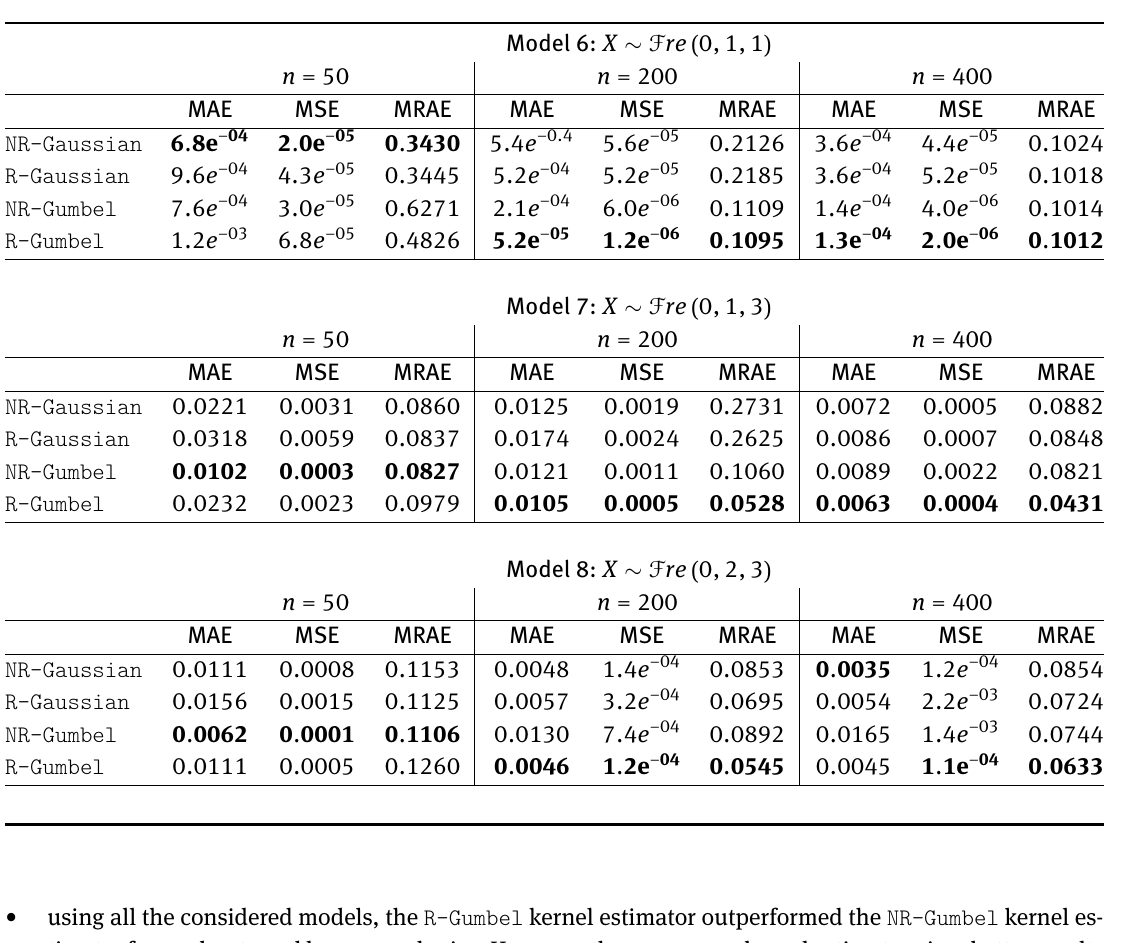
Table 2: Quantitative comparison between the four considered methods. The bold values indicate the smallest values regard- ing the MAE , MSE and MRAE